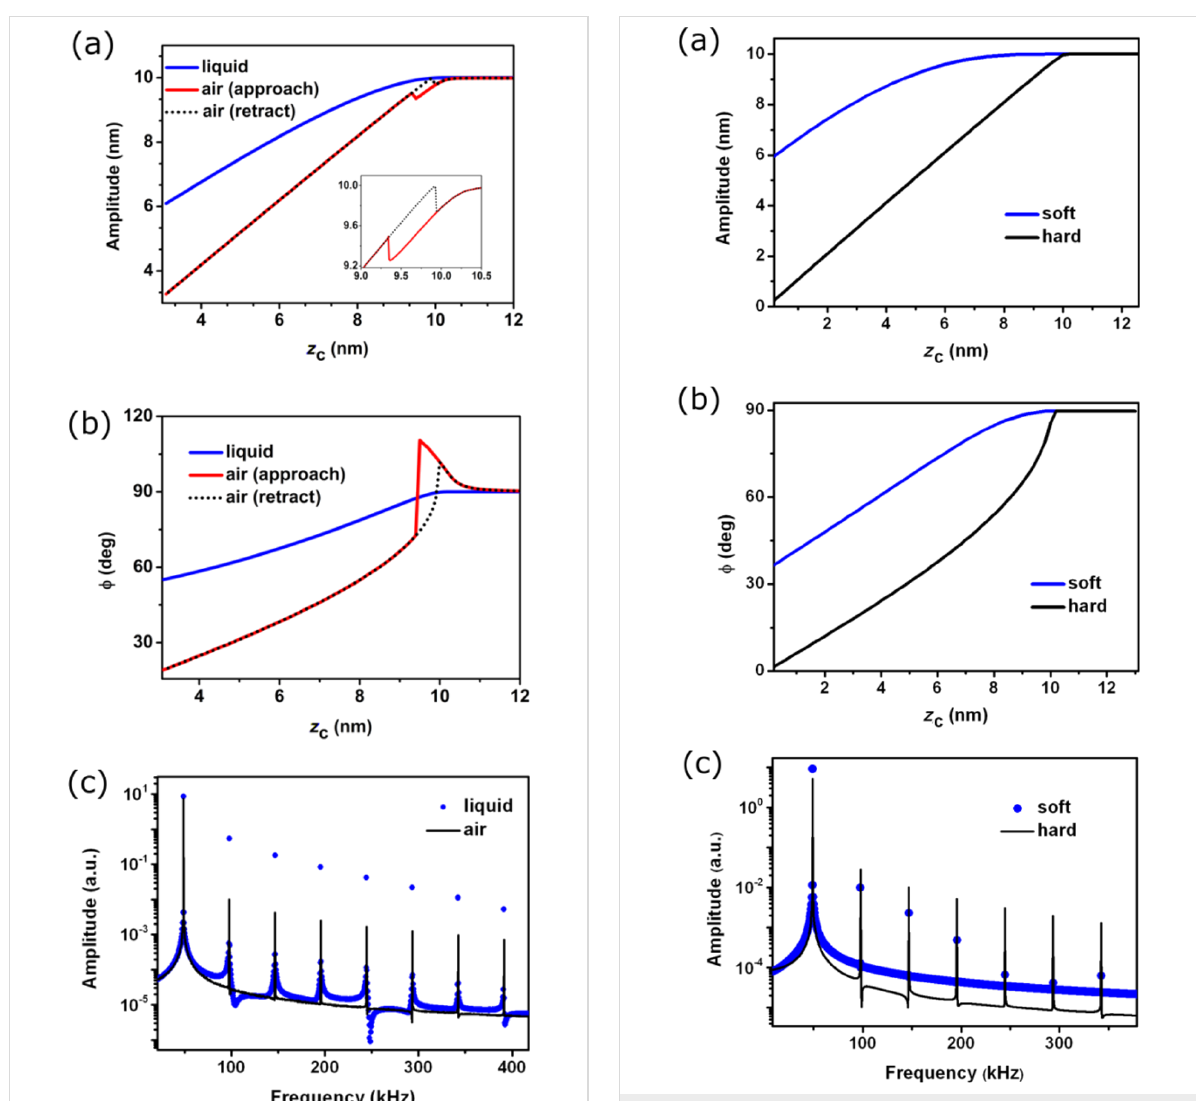
the stiffer material. The amplitude spectrum shows that strength of the higher harmonics also depends on the material. Higher components are observed in the stiffer material (Figure 4c).